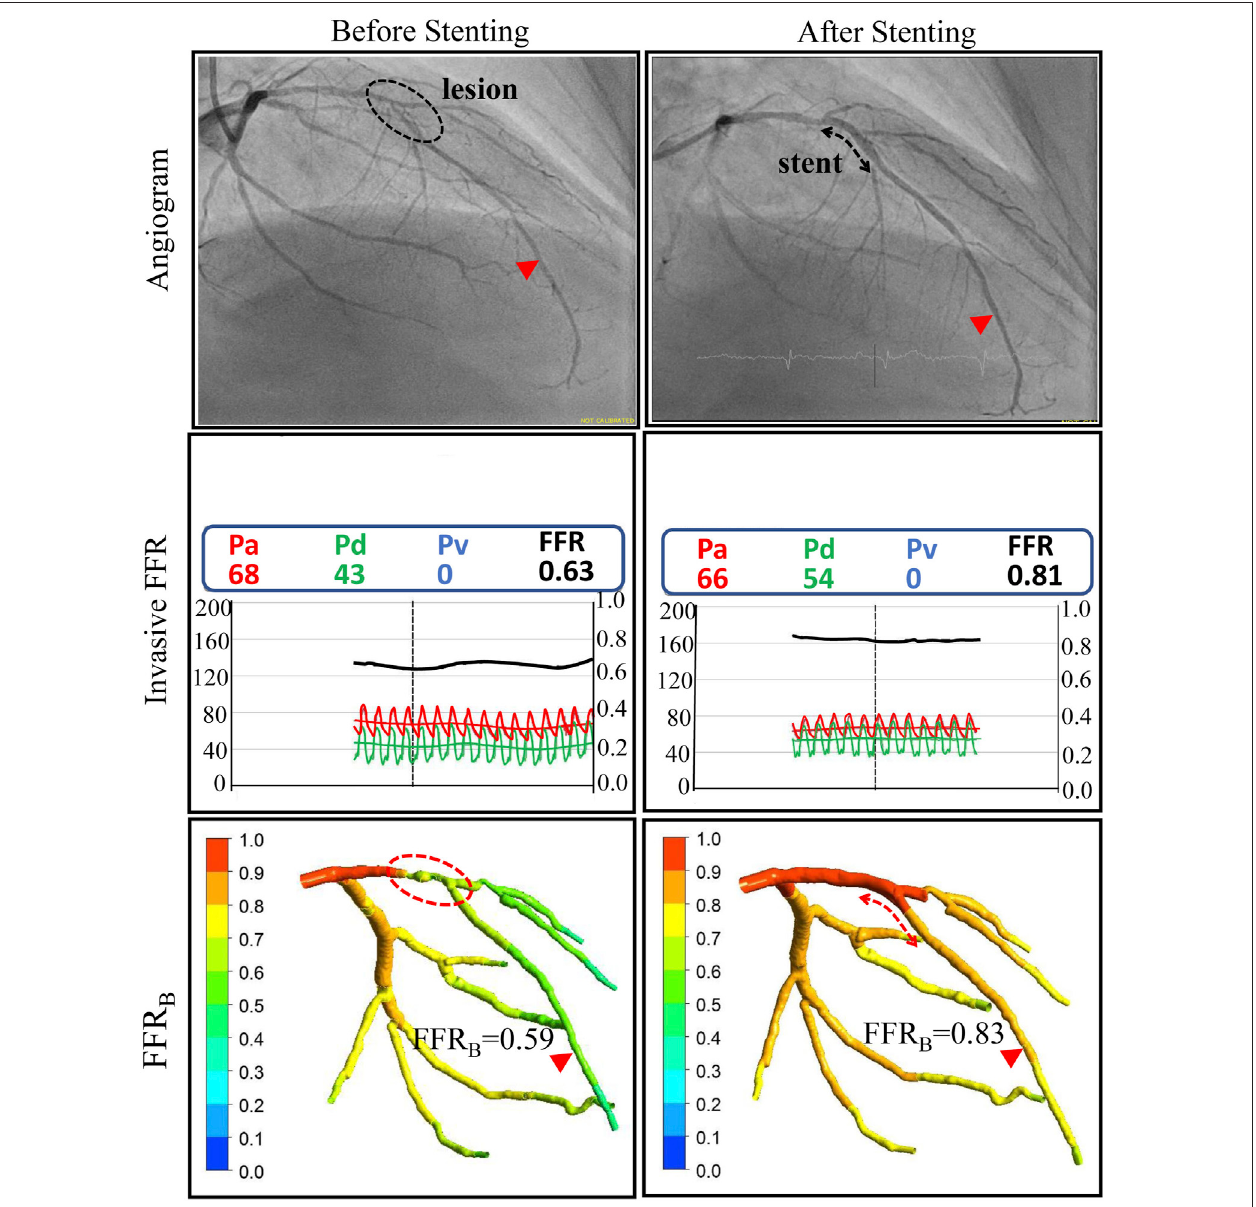
FIGURE 3 | Comparison of invasive and non-invasive functional assessment before and after coronary stenting for one of the patients. Left column: ICA and invasiveFFRcon fi rmedthepresenceofafunctionallysigni fi cantlesionontheLeftAnteriorDescending(LAD)coronaryarterywithanFFRvalueof0.63.Non-invasiveFFR (FFR B ) obtained using CTCA imaging successfully classi fi ed the lesion as functionally signi fi cant with an FFR B value of 0.59. Right Column: After stent implantation invasive FFR was 0.81 and the corresponding FFR B calculated on virtual stenting was 0.83, both indicating no residual ischemia.